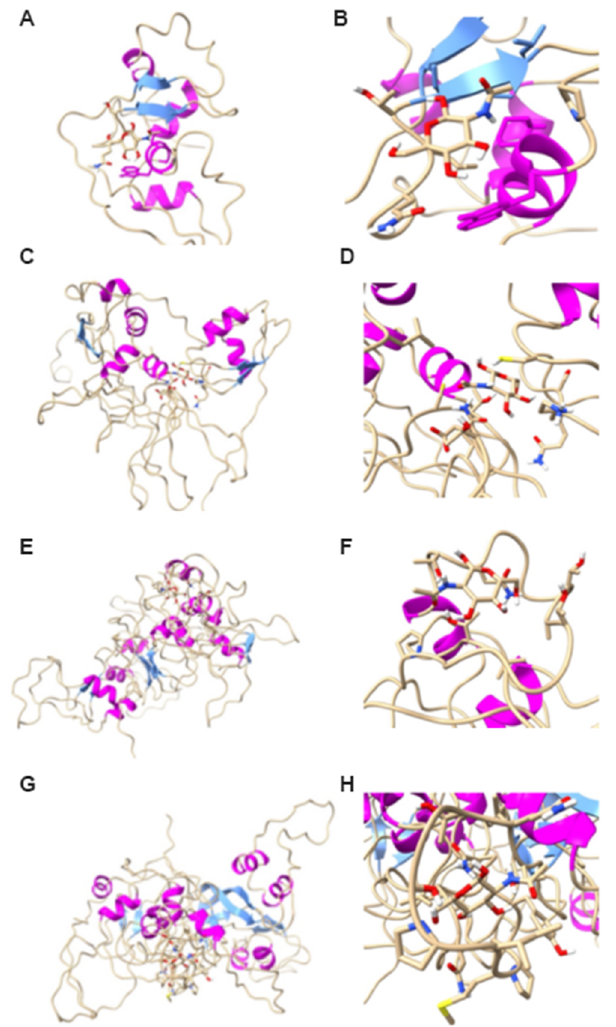
Figure 4. Molecular docking of putative LysM effectors of Pc123. GlcNAc binding model to all putative Pc123 LysM effectors. ( A ) Pc123Lys1; ( B ) broadening of the GlcNAc binding site to Pc123Lys1; ( C ) Pc123Lys2; ( D ) broadening of the GlcNAc binding site to Pc123Lys2; ( E ) Pc123Lys3; ( F ) broadening of the GlcNAc binding site to Pc123Lys3; ( G ) Pc123Lys4; ( H ) broadening of the GlcNAc binding site to Pc123Lys4.